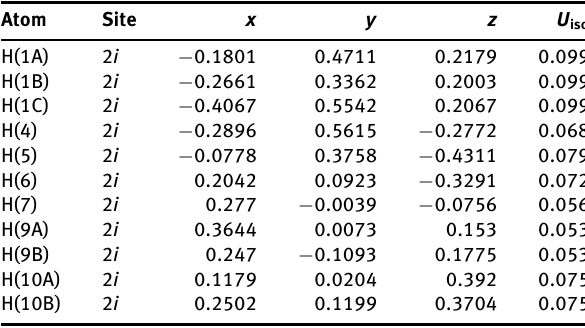
Table 2: Fractional atomic coordinates and isotropic or equivalent isotropic displacement parameters (Å 2